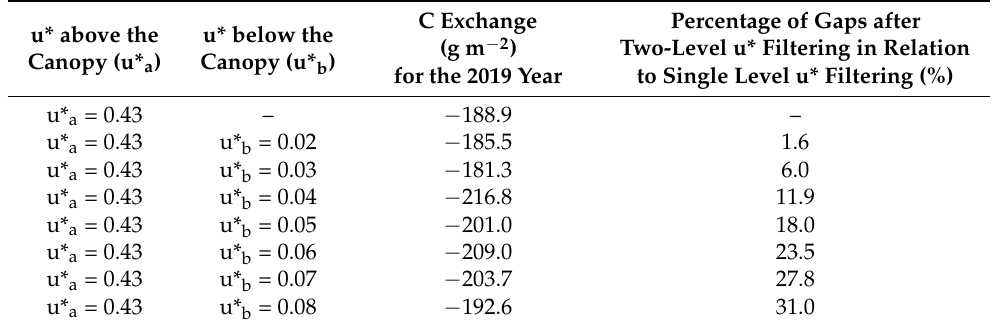
Table 2. Sensitivity analysis for u* b and its influence on the carbon exchange values for